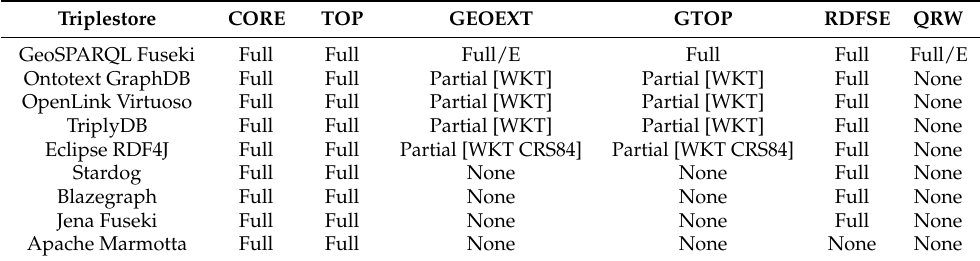
Table 3. Support of the different GeoSPARQL extension by the tested triplestores. Full indicates full support, comprised of correct query answers only, Full/E indicates that support is implemented but erroneous, Partial [GML/WKT] indicates that support is partially implemented, None indicates that support for this GeoSPARQL extension is not